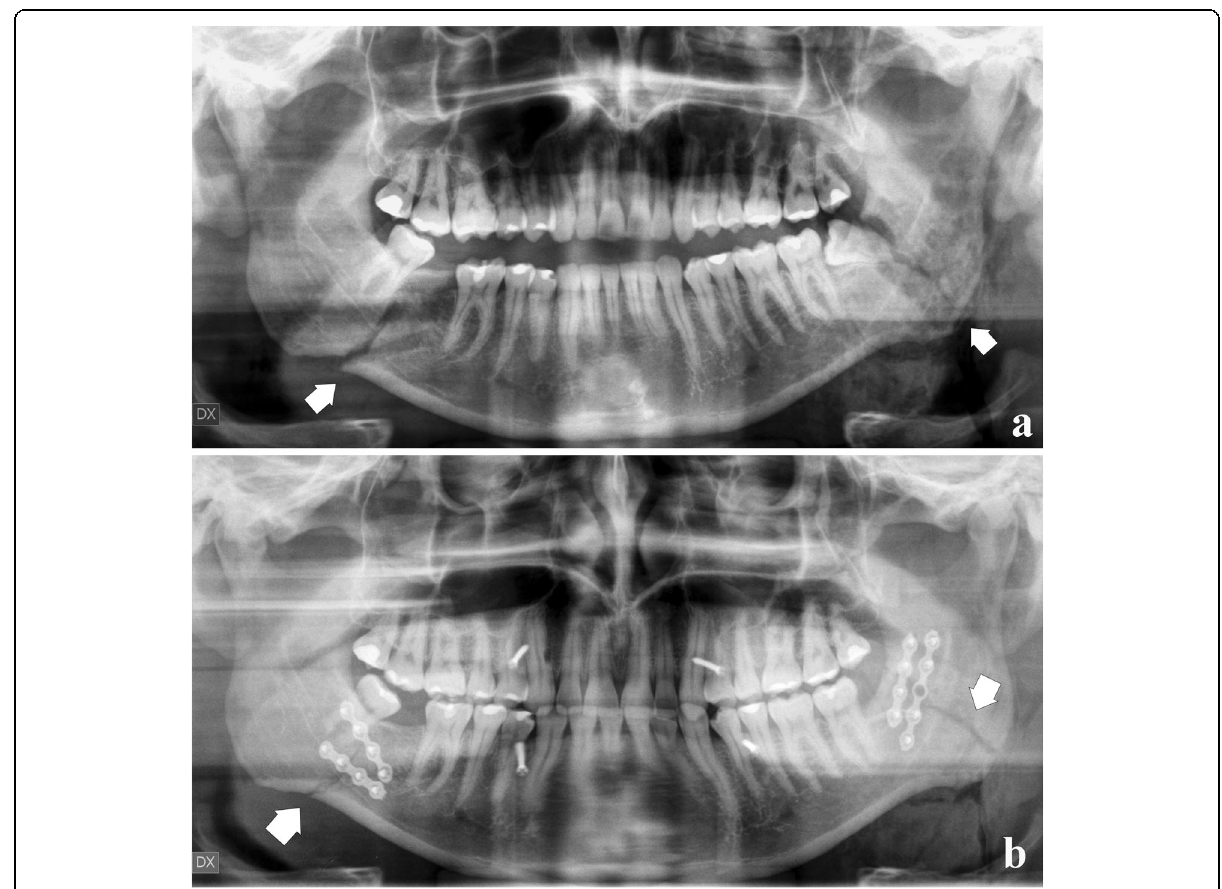
Fig. 22 Bilateral angle fracture. a Panoramic radiograph shows fractures of both mandibular angles (arrows) involving the lower third molars. b After removing the lower left third molar, rigid internal fixations with osteosynthesis plates merge the bone